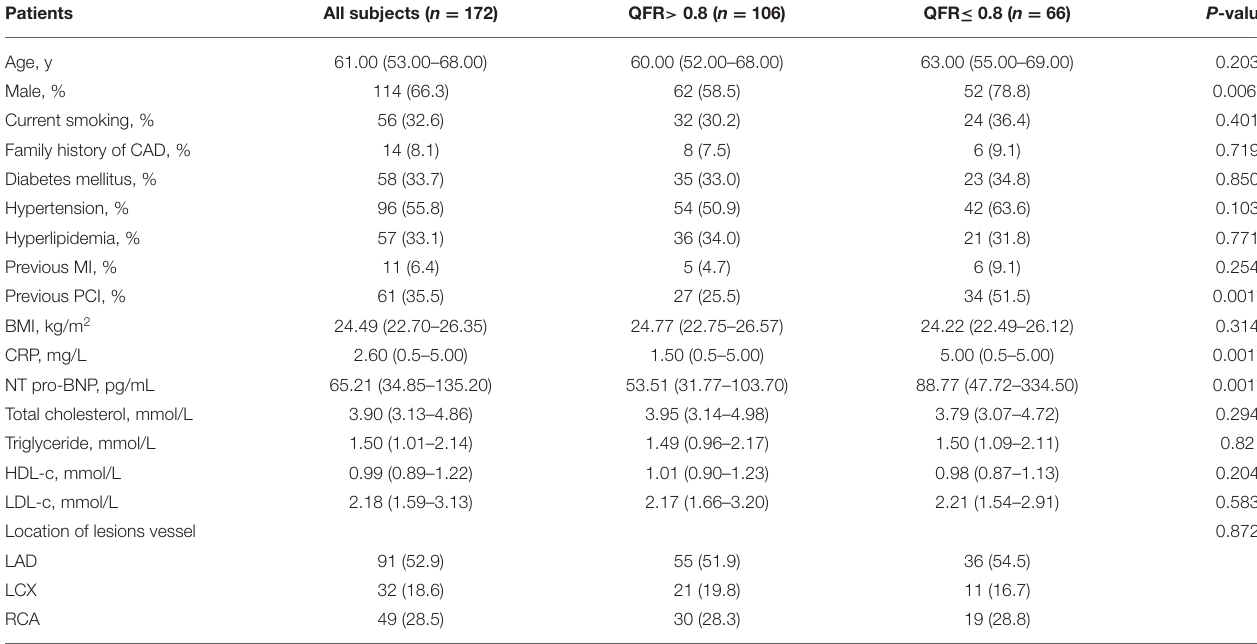
TABLE 1 | Baseline characteristics of QFR > 0.8 of the target vessel and QFR ≤ 0.8 of the target vessel. Patients